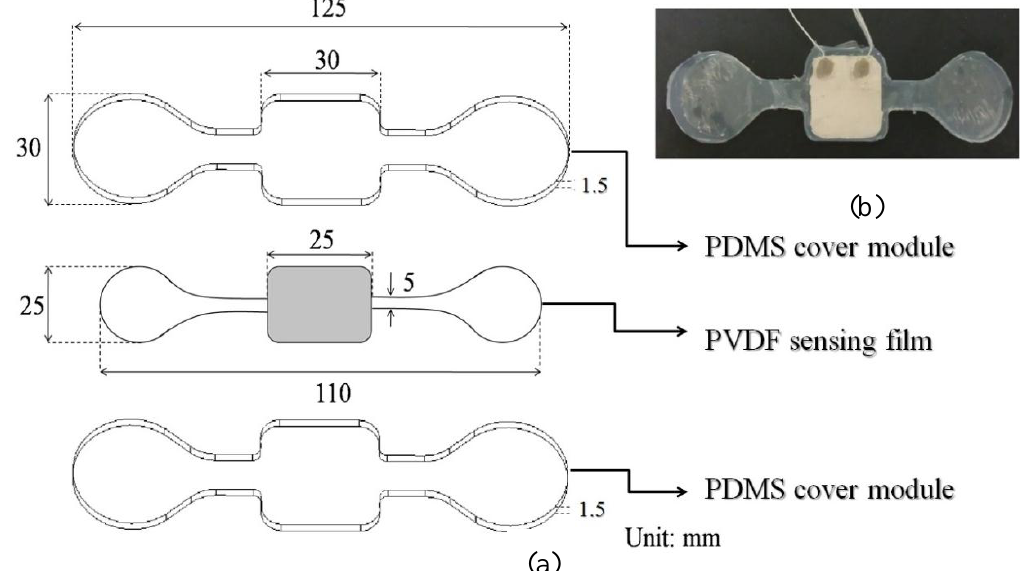
Figure 1. ( a ) Schematic illustrations of the structure of sensor patch, and ( b ) the photograph of sensor patch ( upper right